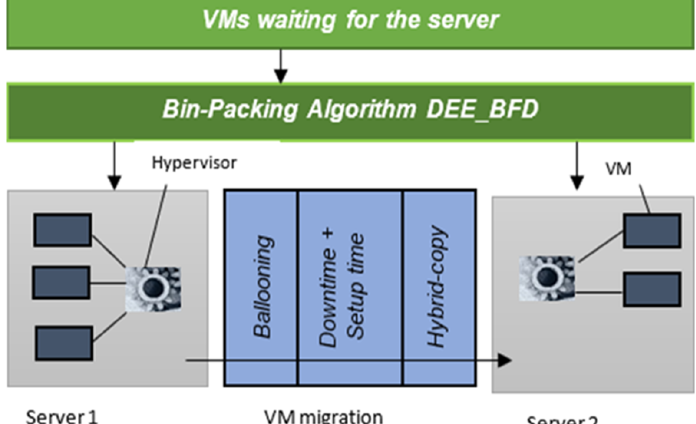
Figure 2. LMB framework.